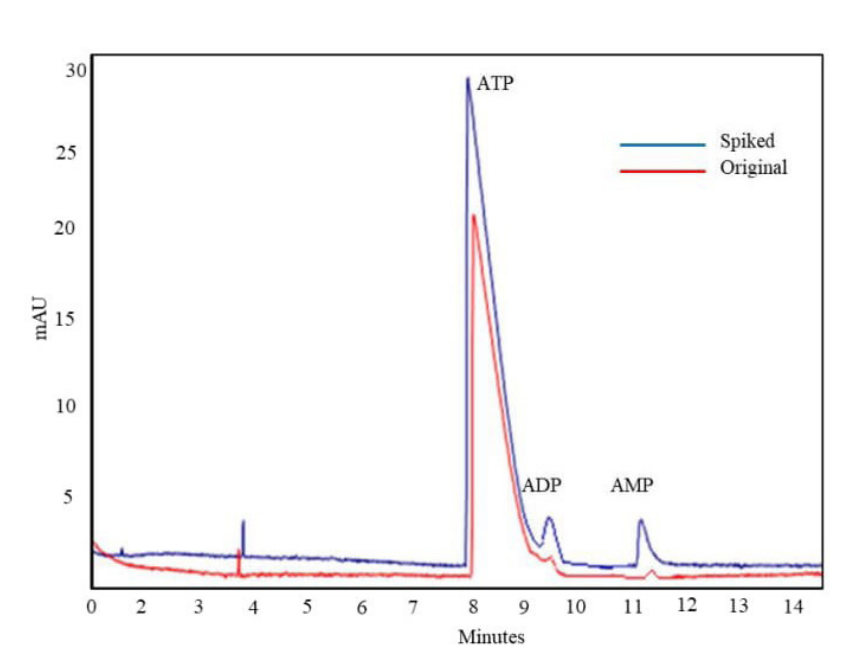
FIGURE 4 - Electropherogram of the analytes in the Douglas tablets (spiked vs.